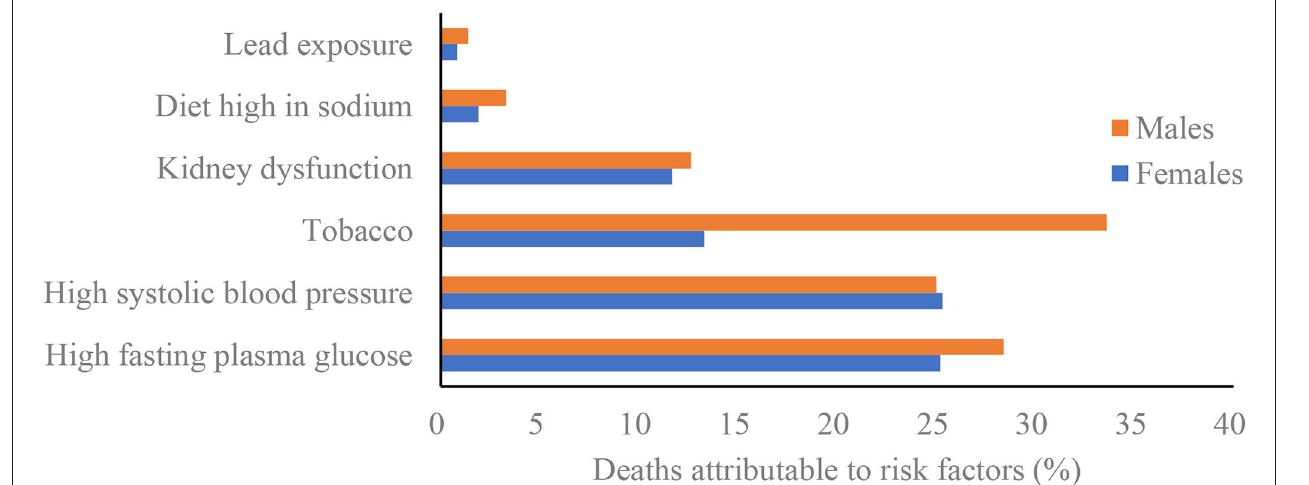
FIGURE 4 | Percentage contributions of major risk factors to peripheral artery disease age-standardized deaths by sex, 2019.